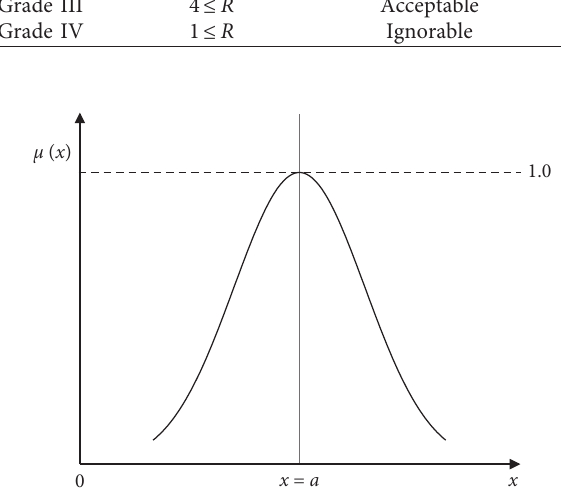
Figure 1: Normal distribution membership function.